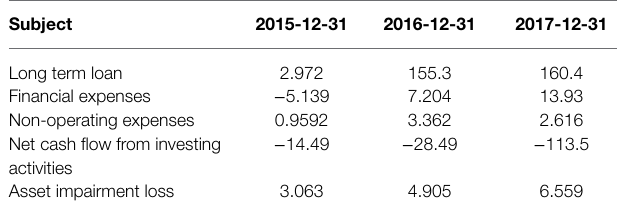
TABLE 5 | Changes in some financial statement items of